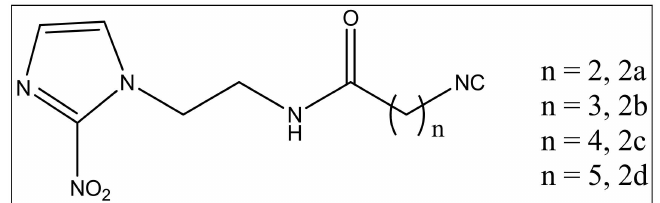
Figure 3. Molecular structure of isocyanide derivatives of 2-nitroimidazol 2a , 2b , 2c , 2d